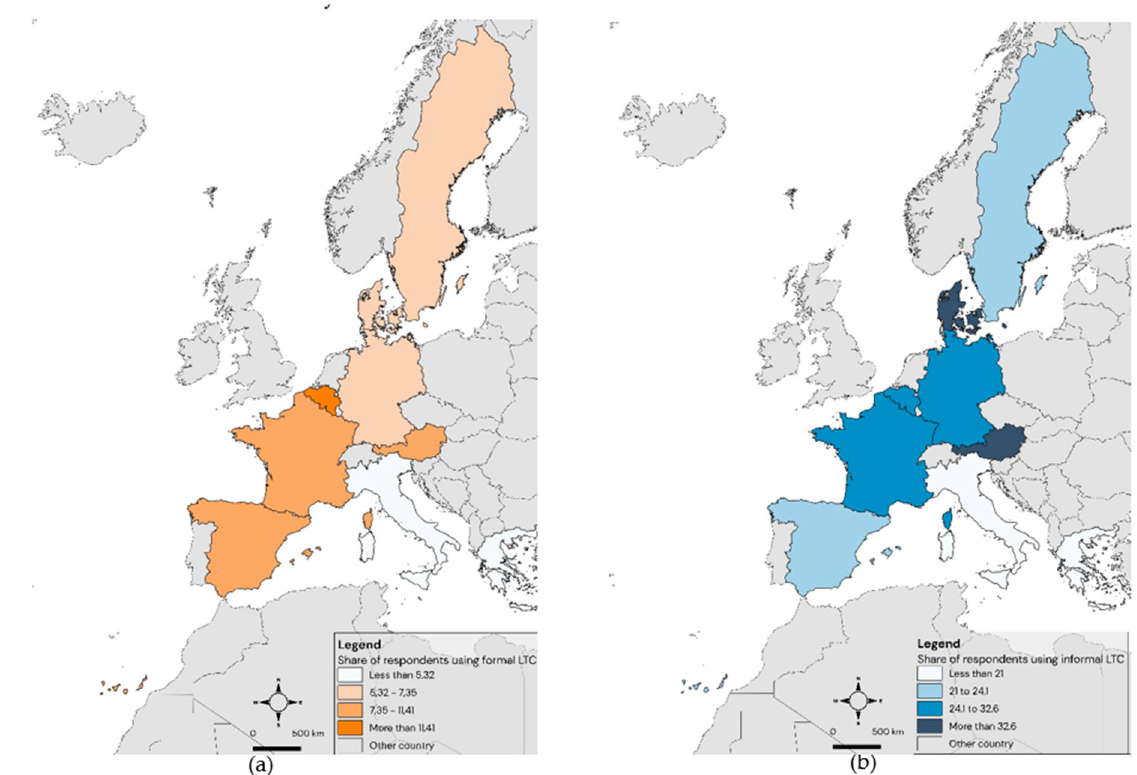
Figure 1. Share of respondents that declare using formal care ( a ) and informal care ( b ). Source: authors’ elaboration based on the Survey of Health, Aging, and Retirement in Europe (SHARE) (Wave 7).